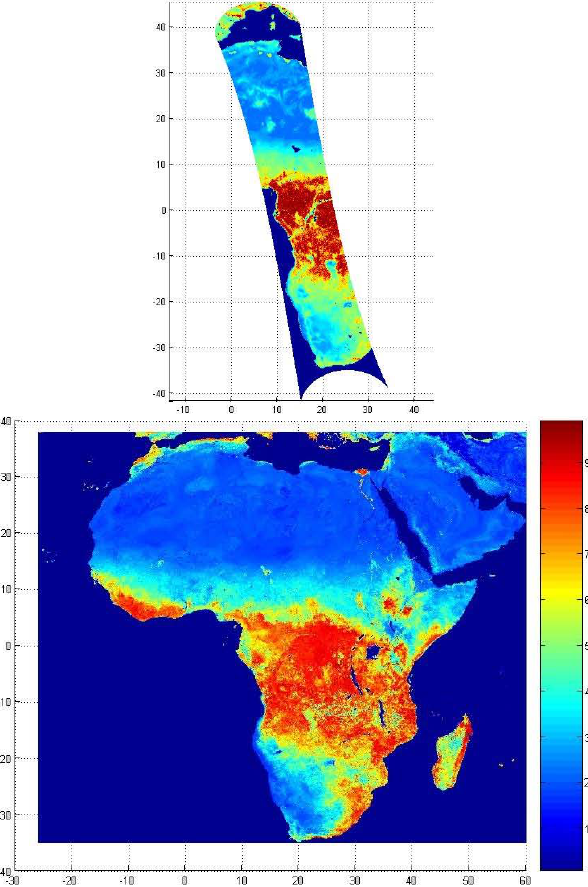
Fig. 15. Vegetation maps of PWC for the entirety of Africa extracted from PI X (top) and NDVI (bottom), respectively. The relationship between NDVI and PWC was derived from Jackson et al.